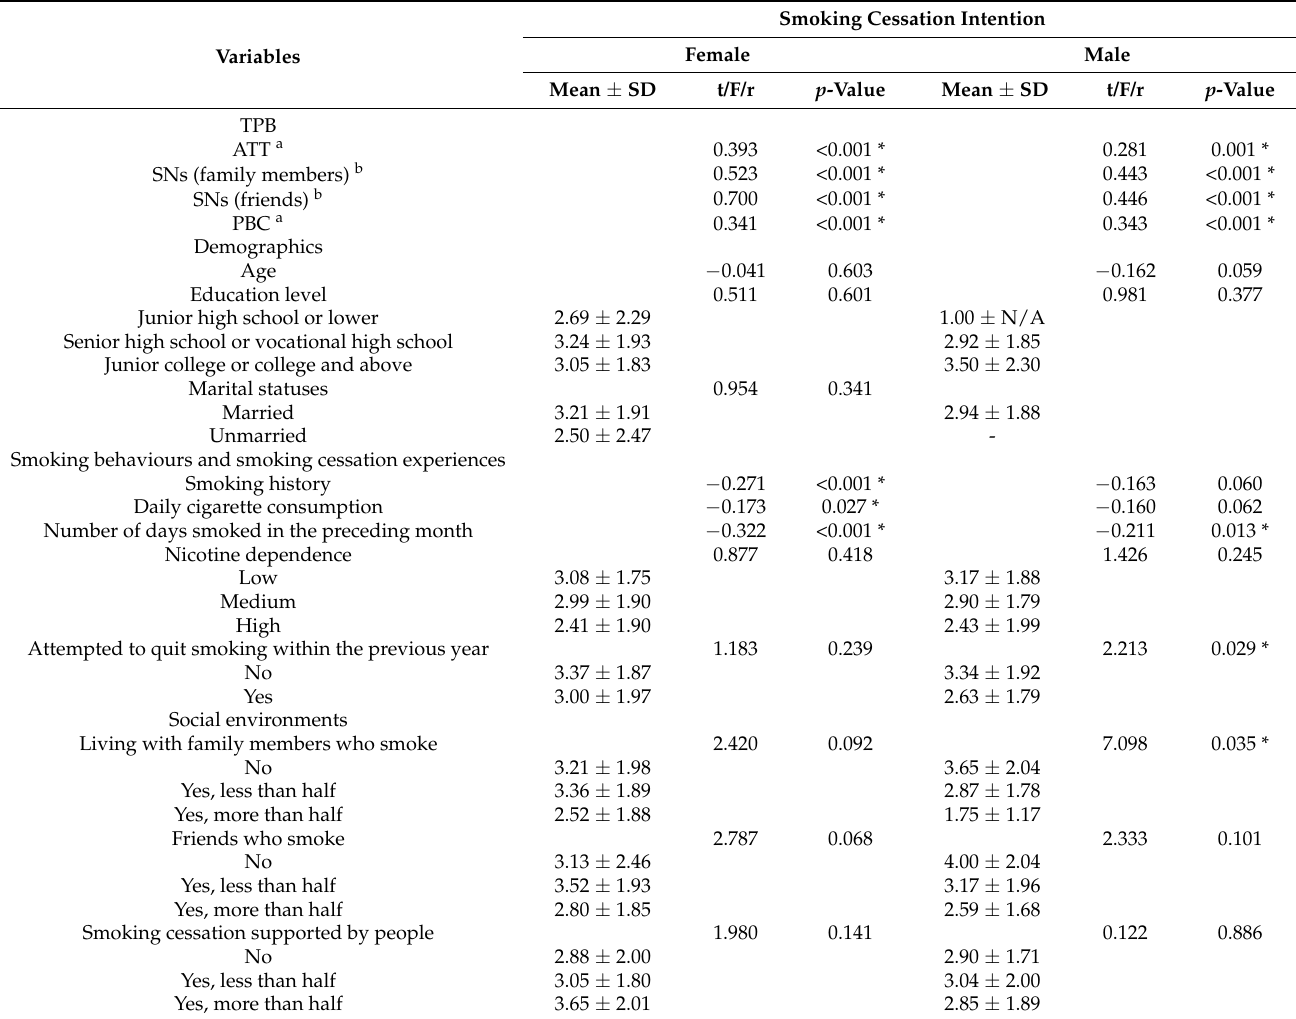
Table 3. Univariable analysis of TPB, demographics, smoking, and social environments on smoking cessation intention by